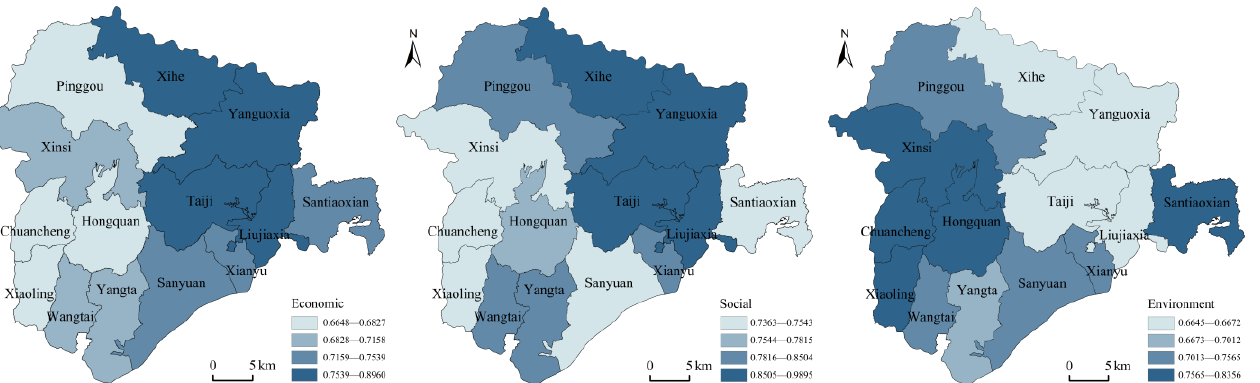
Table 7. Comprehensive evaluation results and coordinated development types of ecological mi- gration areas in Liujiaxia Reservoir Area.